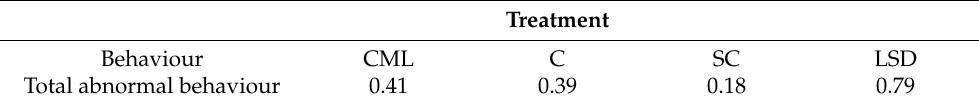
Table 8. Table of back-transformed predicted means for significant effects of treatment, with the least significant difference presented. Treatment groups are as follows: castration + analgesia (CML), castration (C), and sham control